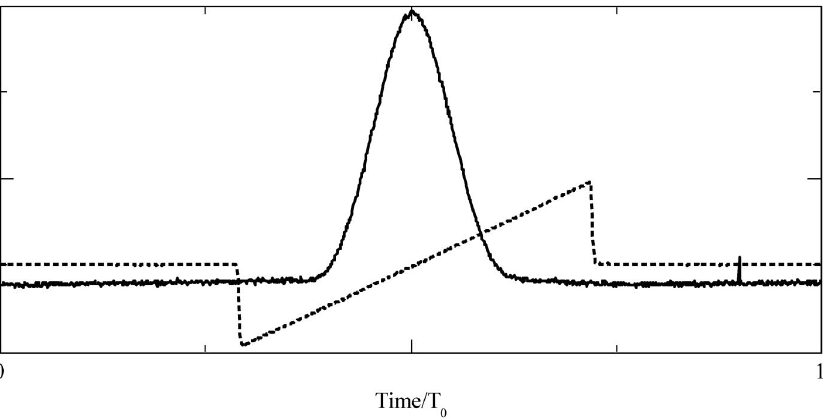
period.FIG. 1. The measured time domain longitudinal bunch distribution (solid line, arbitrary units) and the linear-ramp rf waveform (dashed line, 4 kV peak-to-peak) for antiprotons in the Recycler for one revolution period.